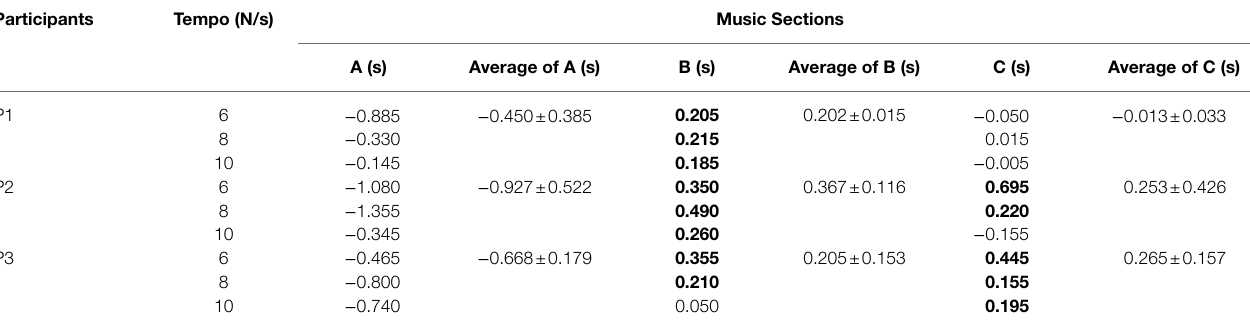
TABLE 2 | The initiation intervals between the trunk and RH for all three sections of the music across the three tempos. Trunk initiations are in bold print. Participants Tempo